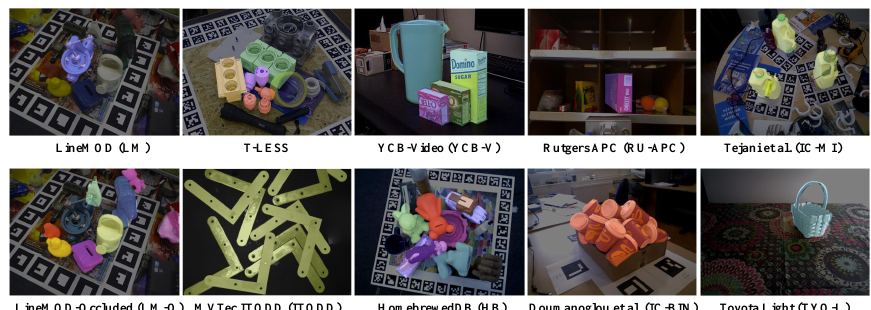
Figure 3. Benchmark for 6D Object Pose Estimatio (BOP) [43]. Note that multiple datasets for 3D object detection were also collected for